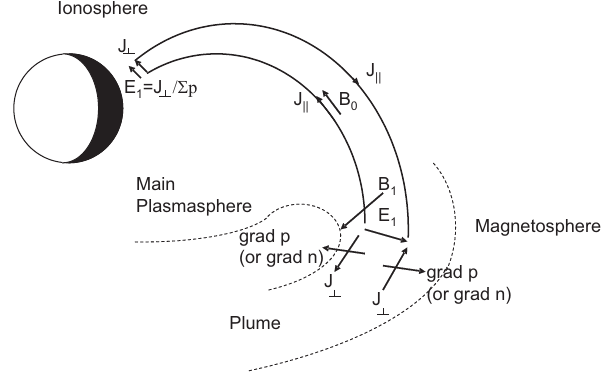
Fig. 14. One possible configuration of current system connecting the magnetosphere to the ionosphere. The current source is assumed to be a pressure gradient in the